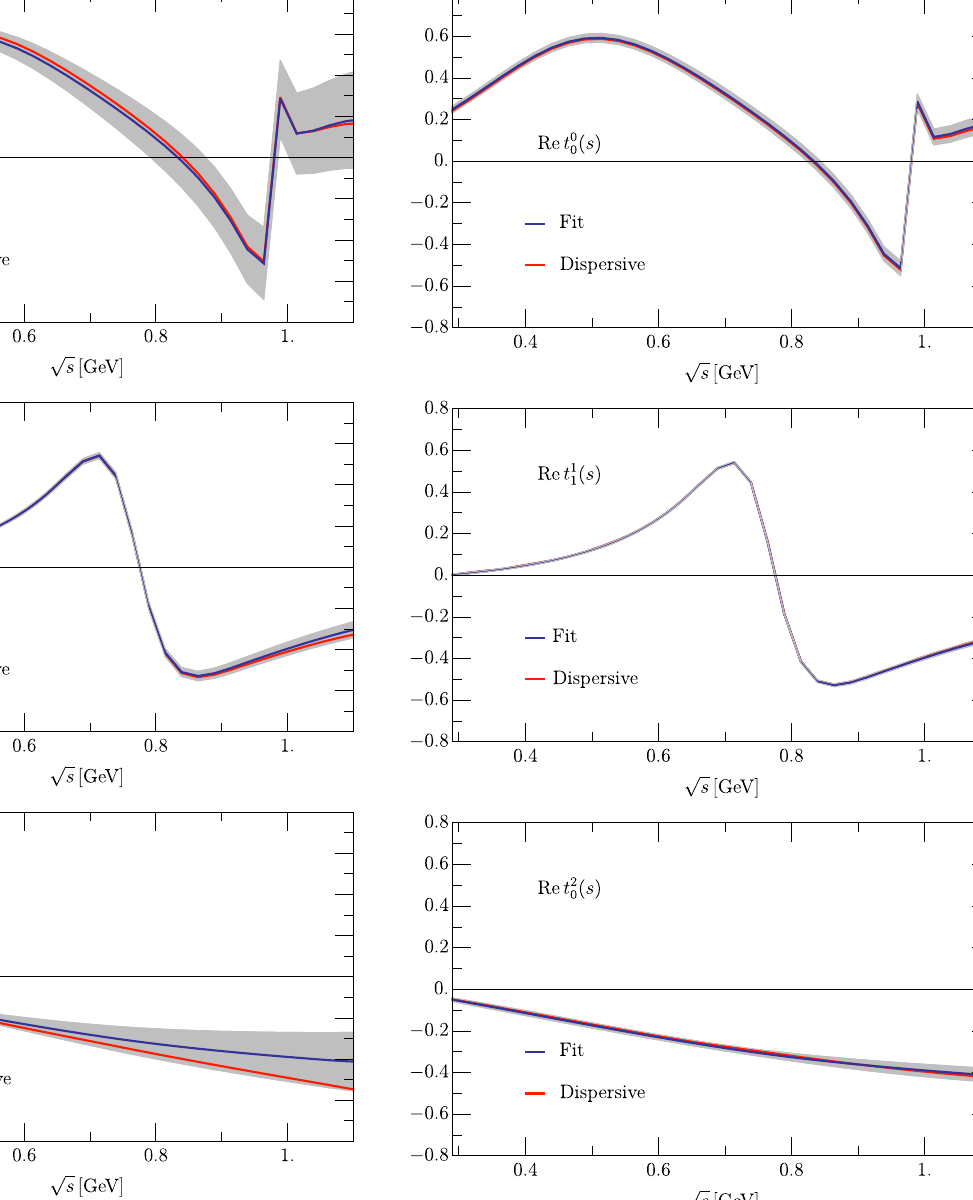
Fig. 7 Results for GKPY equations. Blue lines: real part coming from our new parameterizations. Orange lines: the result of the dispersive integrals. The gray bands cover the uncertainties in the difference between both. From top to bottom: a S 0 wave, b P wave, c S 2 wave